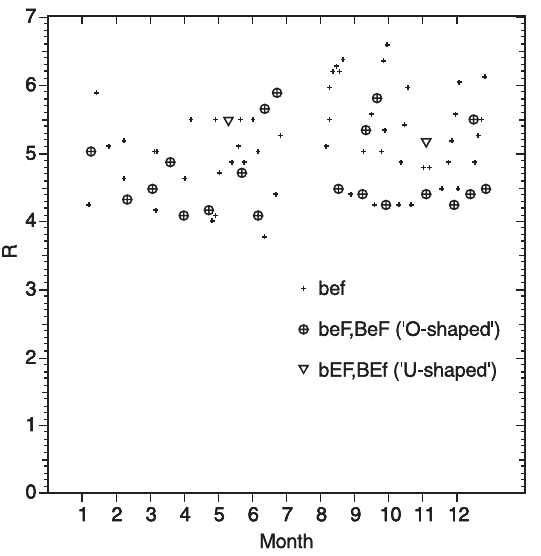
Fig. 7. The MLT and magnetic latitude distribution of the events. Weak events are marked with (cid:139), events with magnetic field signatures but weak electric fields by (cid:8) , and events where the electric field is strong by a triangle . There are two triangles in the plot which happen to overlap each other